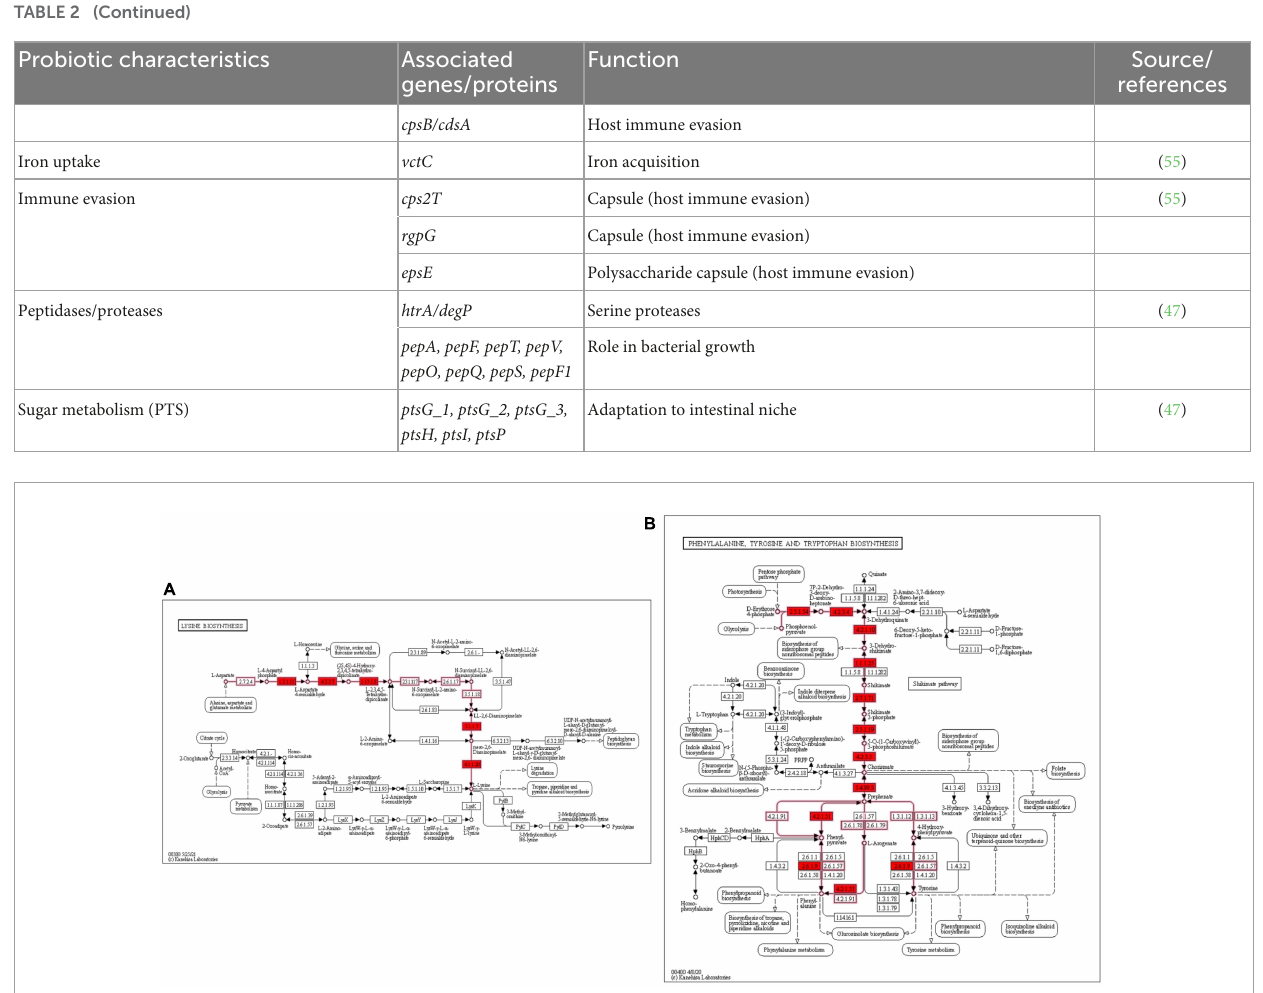
FIGURE2 KEGG metabolic pathway for biosynthesis of essential amino acids lysine and aromatic amino acids in E. faecium LR13 (A) lysine biosynthesis genes are highlighted in red (B) phenylalanine and tyrosine biosynthesis genes are highlighted in red. The pathway maps were created using the KEGG